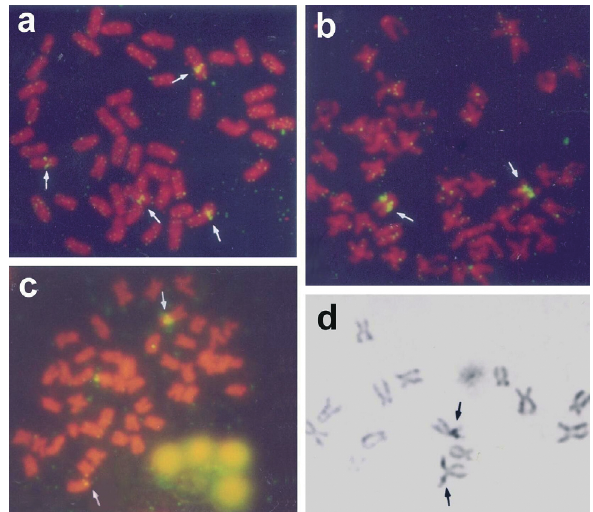
Figure 4 - Chromosomes bearing ribosomal sites. Fish with the 5S rDNA probe in (a) S. fuscus (four signals) and (b) S . variabilis (two signals). (c) Fluorescence in situ hybridization with the 18S rDNA probe showing the rDNA sites located in the secondary constrictions in S. fuscus . (d) Ag-NOR signals in S. fuscus